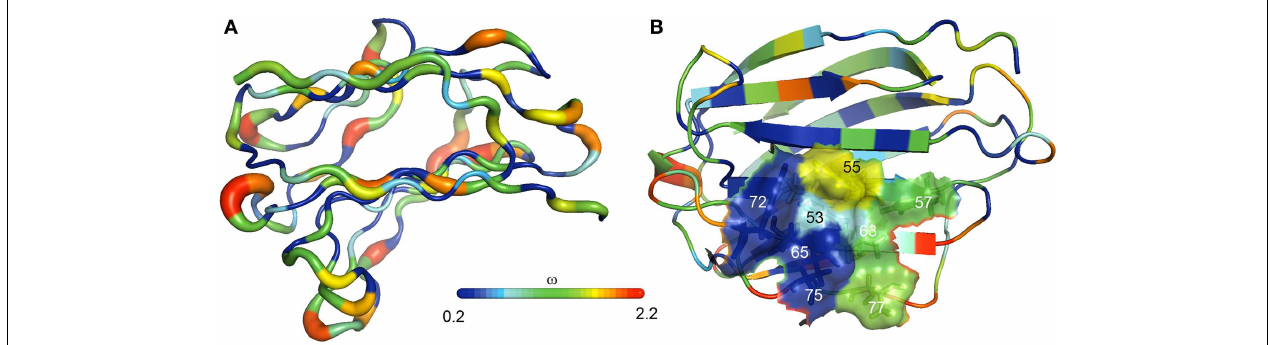
color spectrum on the bar, is the smallest along β -strands and highest in loop regions. (B) The same color coding shows that four residues in the PP13 CRD (residues: 53, 65, 72, 75) have been conserved in chromosome 19 cluster galectins, while the other four residues on the opposite side of the CRD (residues: 55, 57, 63, 77) show more evolutionary changes among these